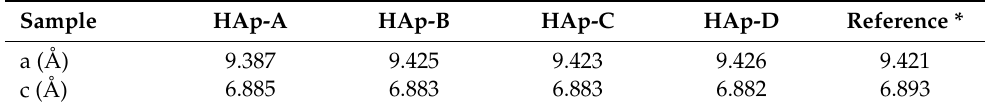
Table 1. The lattice constant of the HAp powders.